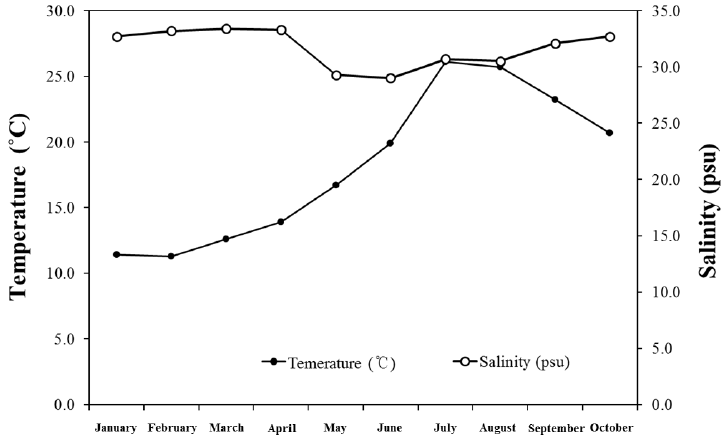
Figure 2. Monthly changes in the surface water temperature and salinity at the sampling site from January 2021 to October 2021. psu, practical salinity unit.